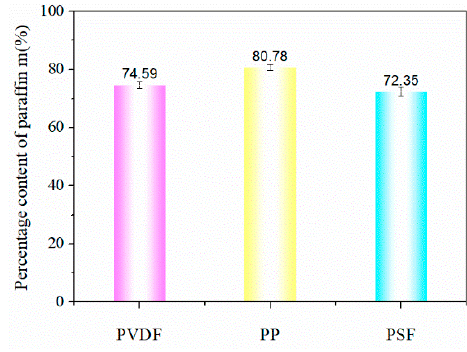
Figure 5. Percentage content of paraffin in the encapsulation membrane.